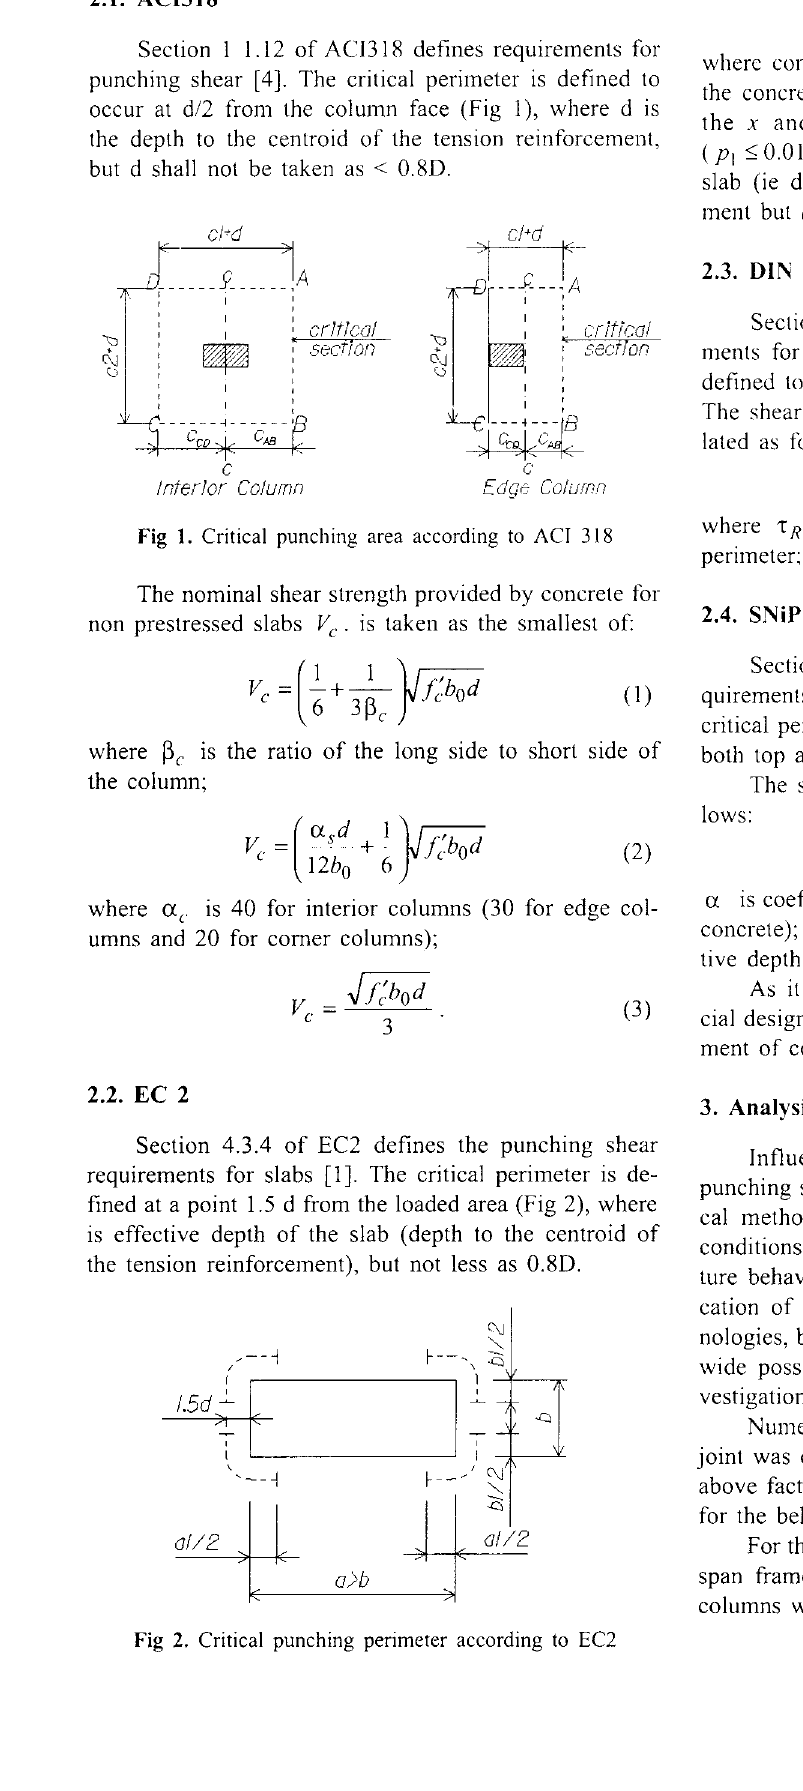
Fig 2. Critical punching perimeter according to